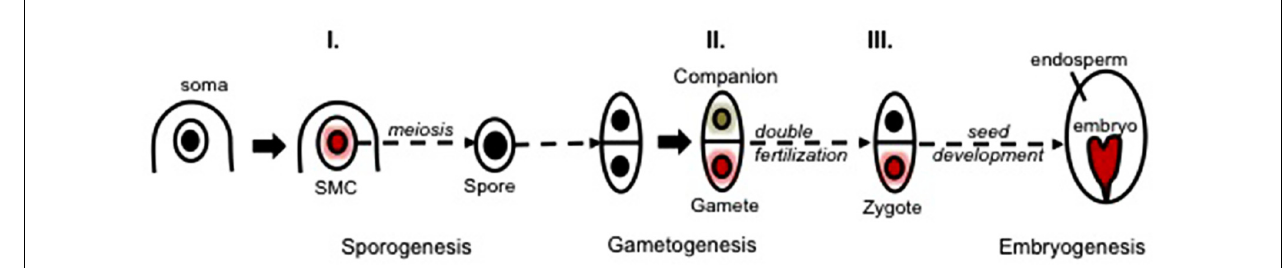
FIGURE 5 |Three main waves of chromatin dynamics during plant reproduction (Model). Sexual plant reproduction can be seen as a three-step process involving sporogenesis, gametogenesis, and embryogenesis taking place in floral organs. Sporogenesis initiates with the specification of spore mother cells (SMCs) within the sporangium tissues. SMCs are primed toward meiosis while undergoing a somatic-to- reproductive cellular fate transition that generates a pluripotent spore.The spore develops a (male or female) multicellular gametophyte generating distinct cell types: the companion (or accessory) cells and the gametic cells (a schematically reduced form is shown, for more details see Figure 1 ).